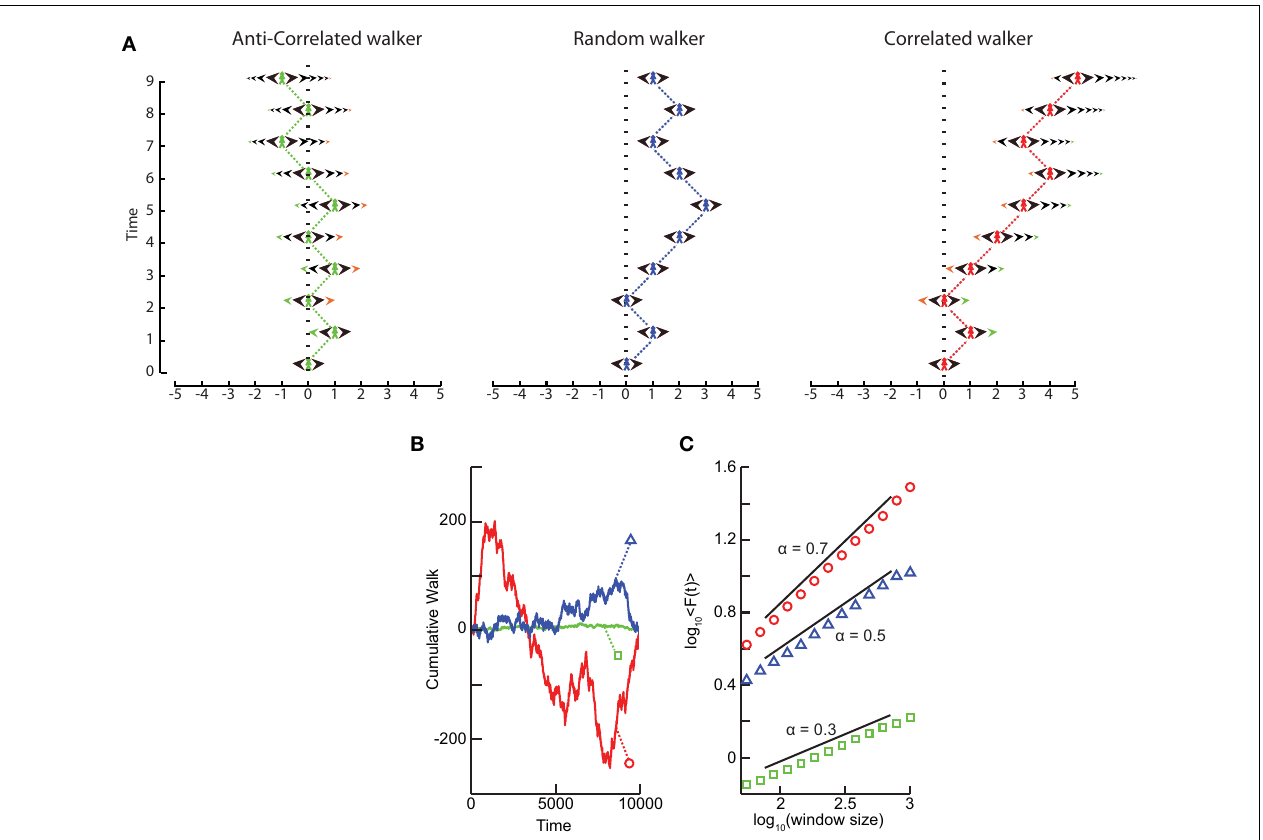
shown over time.The random walker is not influenced by previous actions and so always has equal probability of going left or right. (Right) Path of a correlated walker shown over time. Here each action the walker takes influences future actions by making the walker more likely to take that action. The green arrows show that by taking the action of going right at time 0, the walker is more likely to go right in future time steps with the influence getting smaller as time goes on. (B) Cumulative signal for a positively correlated process ( red , circle ) shows larger fluctuations over time than a random walker ( blue , triangle ). An anti-correlated signal ( green, square ) shows smaller fluctuations over time. (C) By looking at the average fluctuations for these different processes at different time-scales, we can quantify this difference. A random walker shows a scaling exponent of 0.5, with the positively correlated process having a larger exponent, and the anti-correlated process having a smaller